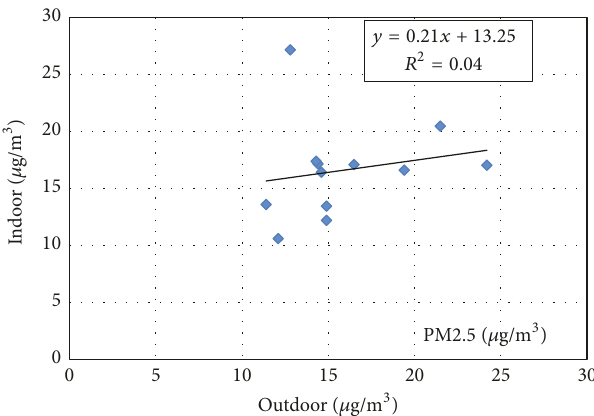
Figure 2: Scatterplot showing the indoor/outdoor correlation for